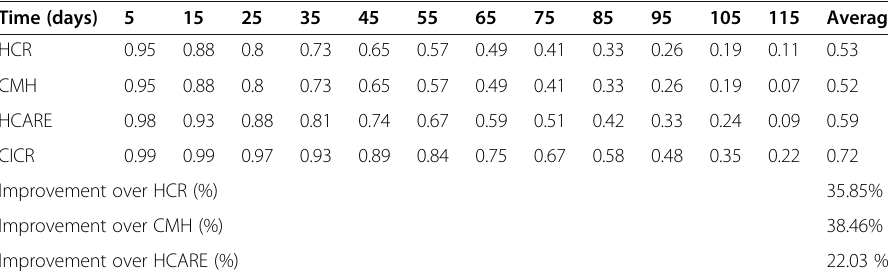
Table 3 Reliability of the region versus time